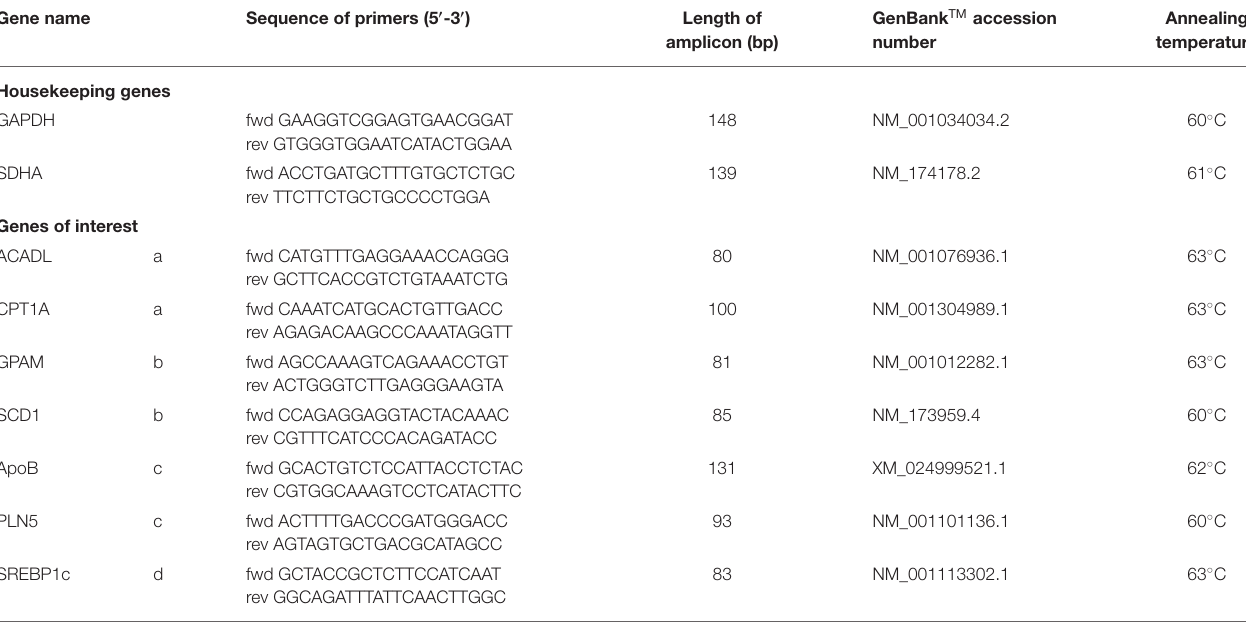
TABLE 1 | Primers of the housekeeping genes (GAPDH, glyceraldehyde 3-phosphate dehydrogenase; SDHA, succinate dehydrogenase complex flavoprotein subunit A) and primers of fatty acid metabolism-related